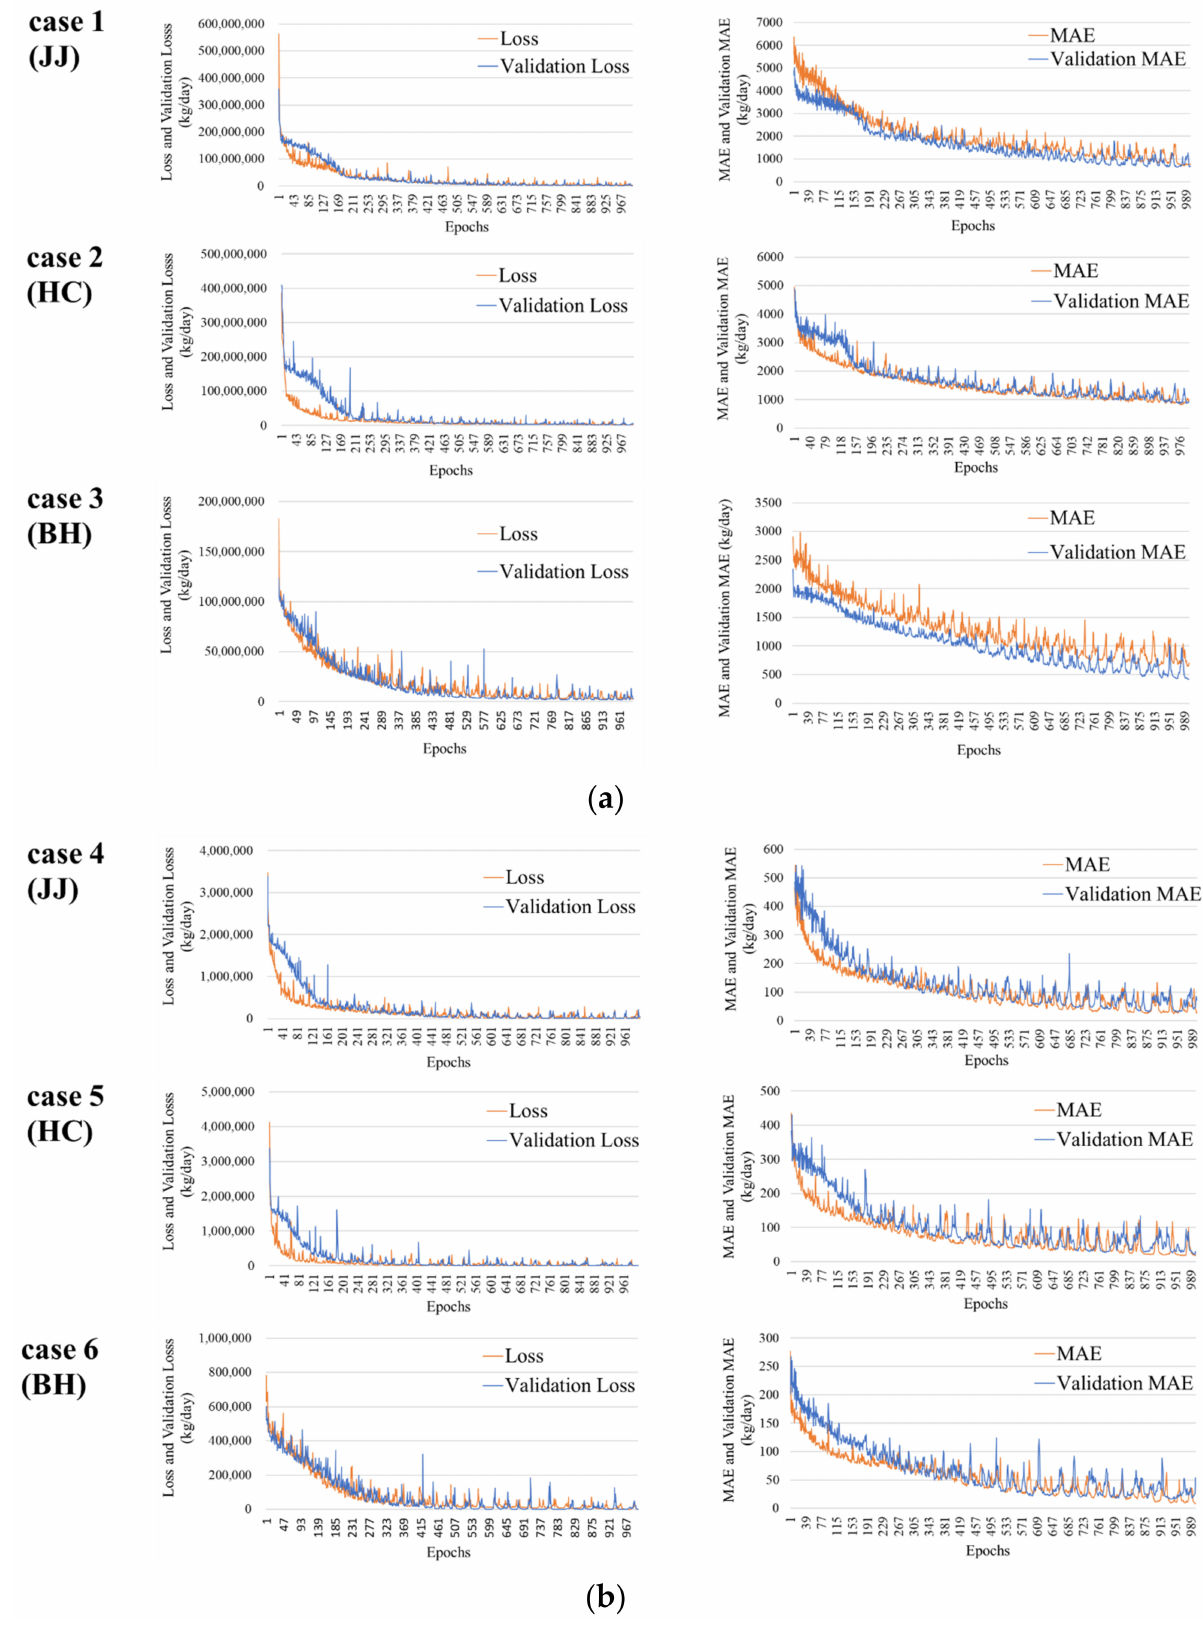
Figure 9. Training results for the CNN models in this study: ( a ) CNN models for BOD load prediction; ( b ) CNN models for TP load